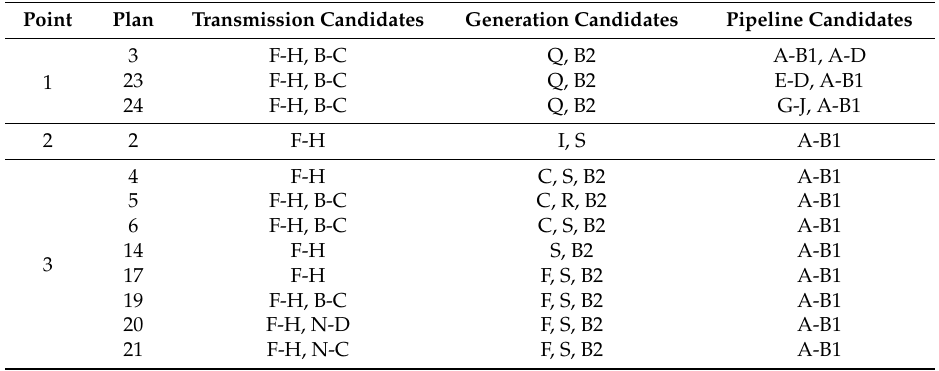
Figure 7. Pareto optimal chart. Table 7. Pareto optimal results.